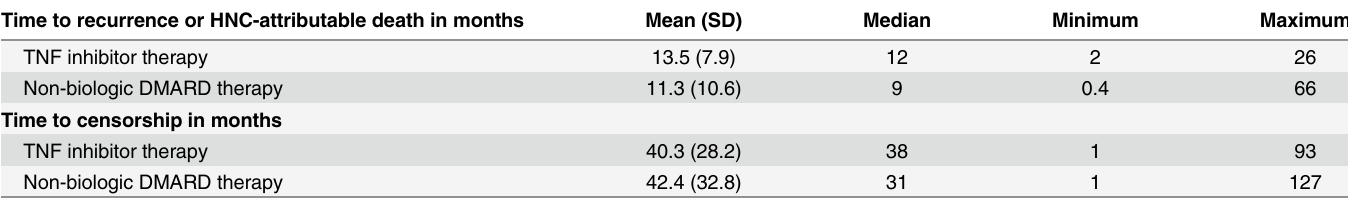
Table 2. Duration of follow-up of head and neck cancer in the two treatment groups.